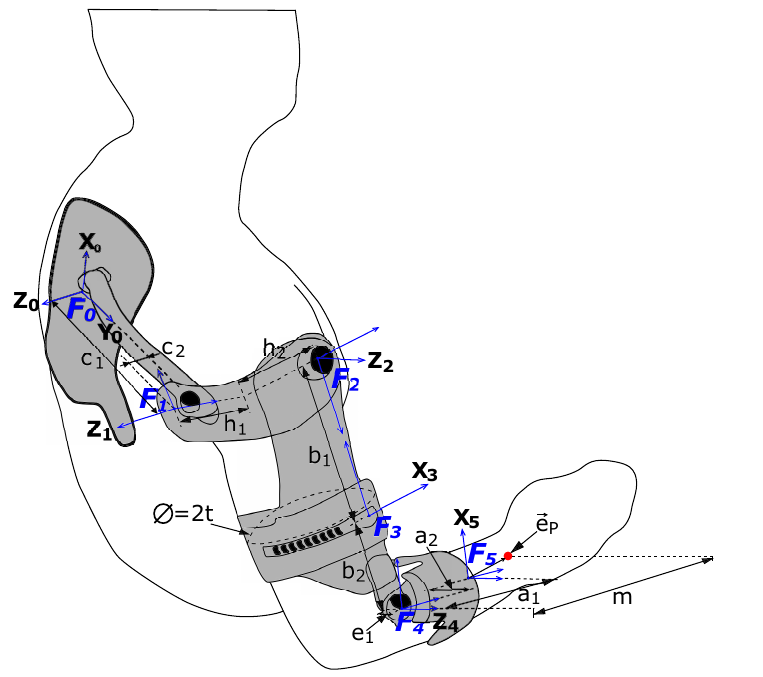
Figure 3. 5 DoF upper-limb exoskeleton vector system. Table 1. ZXZ Euler parameters for the kinematic model of the upper-limb